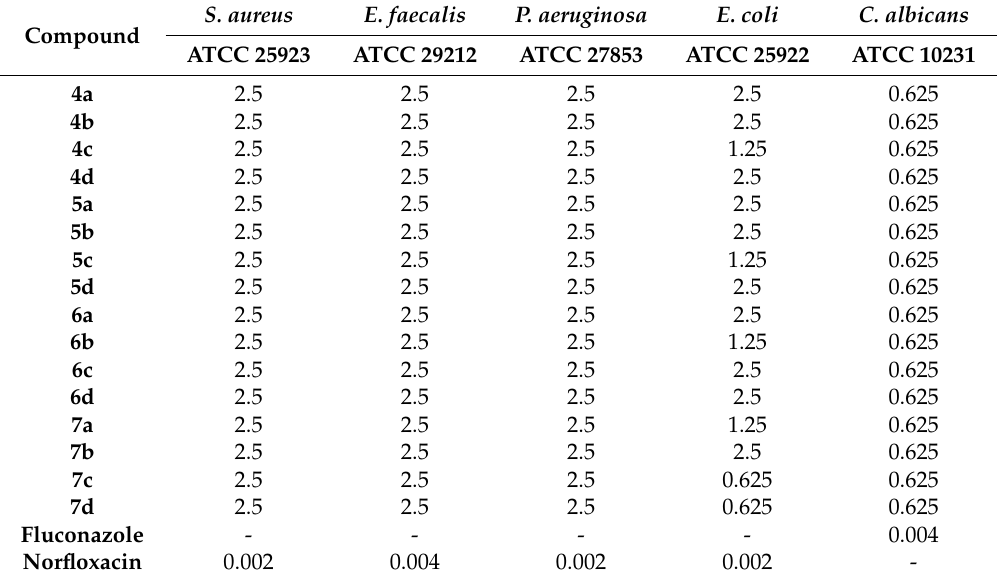
Table 2. The minimum inhibitory concentrations MIC (mg mL − 1 ) values of the new compounds against the tested microbial strains.